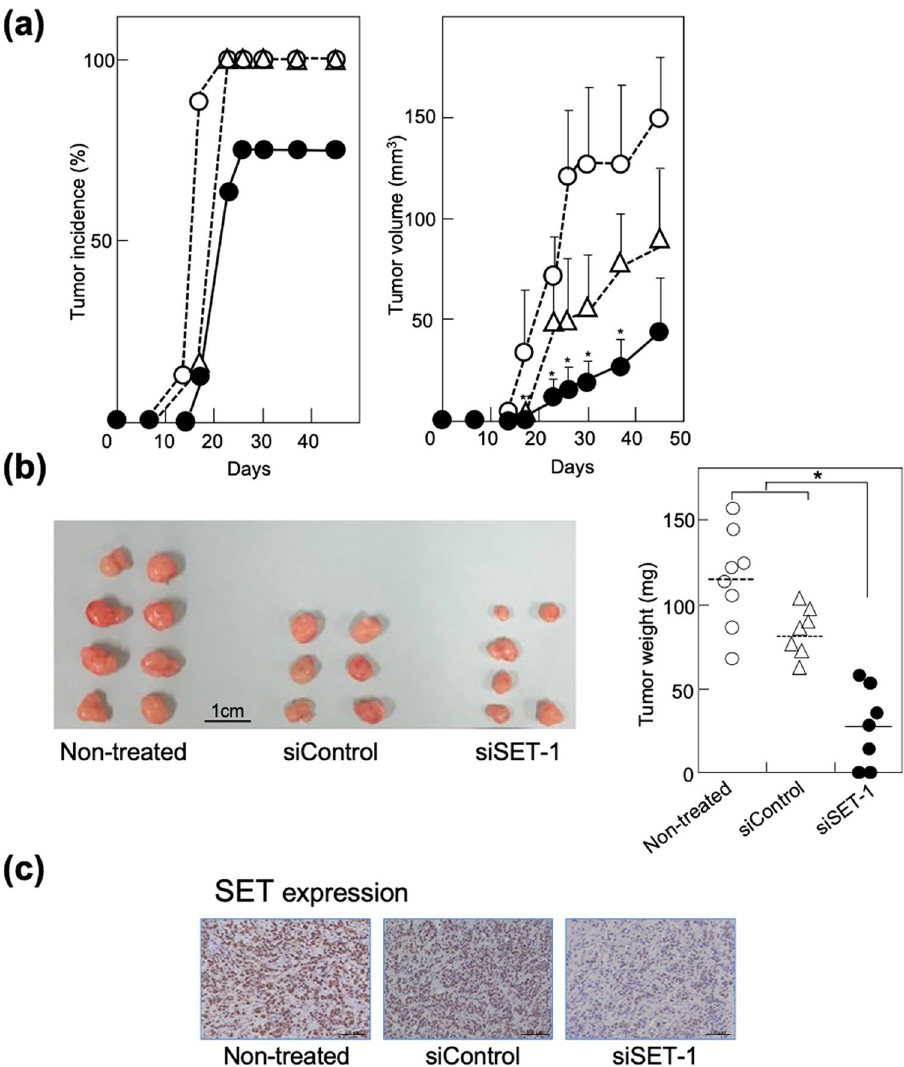
Figure 3. Knocking down of SET inhibited tumour formation of MCF-7 cells in SCID/Beige mice. ( a ) siSET- treated MCF-7 cells ( ) showed lower incidence (right) and smaller tumours (left) than non-treated ( ○ ) and siControl-treated MCF-7 ( △ ) cells. ( b ) The images show all tumours formed in non-treated (8 sites), siControl- ● treated (6 sites), and siSET-1-treated (8 sites) mice at the end of the experiment; the graph indicates the weight of each tumour in the three groups. ( c ) Immunohistochemical analysis showed that SET protein level was significantly lower in tumours developed in siSET-treated group than in those in the non-treated and siControl- treated groups. * P <